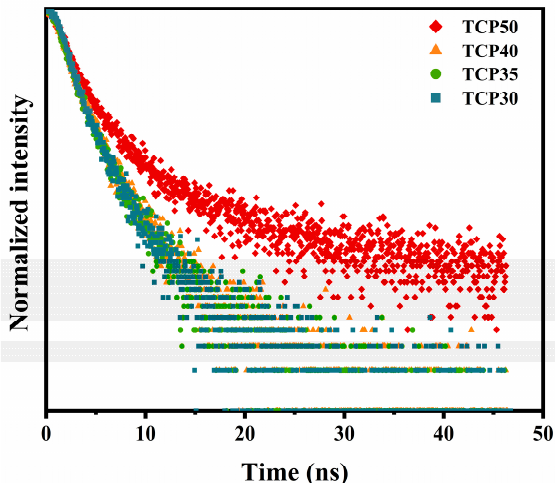
Figure 3. Fluorescence decay curve of TCPZ glasses at 530 nm. Table 1. Emission peak performance parameters of TCP glasses with different Sn/P ratios.